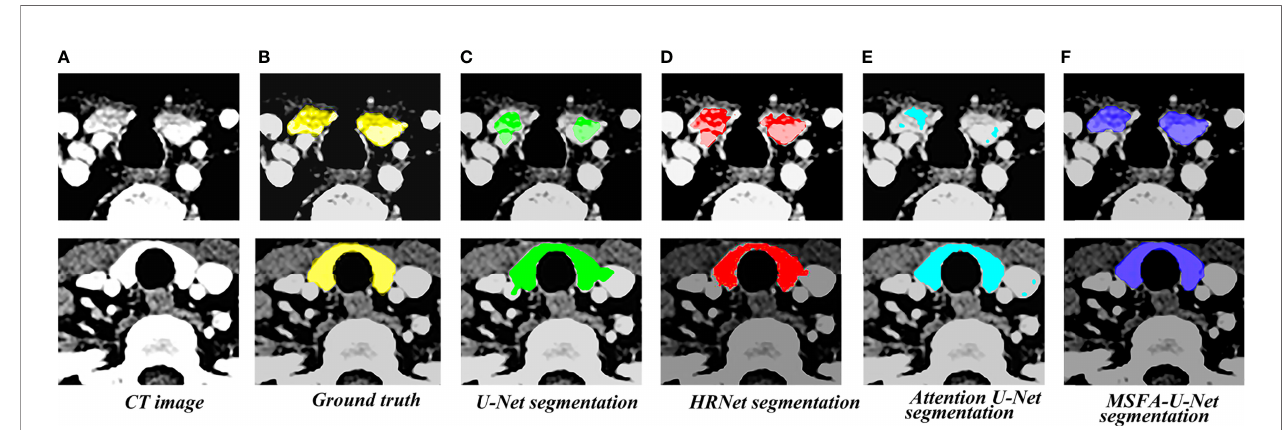
FIGURE 5 | Thyroid coverage map of the four models on localized CT images for radiotherapy. (A) CT image. (B) Coverage map of thyroid of corresponding label image(Ground truth) on CT image. (C) Coverage map of thyroid segmented by U-Net on CT image (D) Coverage map of thyroid segmented by HRUet on CT image. (E) Coverage map of thyroid segmented by Attention U-Net on CT image. (F) Coverage map of thyroid segmented by MSFA-U-Net on CT